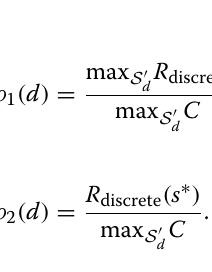
Here R discrete ( s ∗ ) denotes the rate with discrete modulation in the state s ∗ that maxi- mizes capacity. For example, in Fig. 13 s ∗ is state 9, so (24) is the ratio of discrete rate